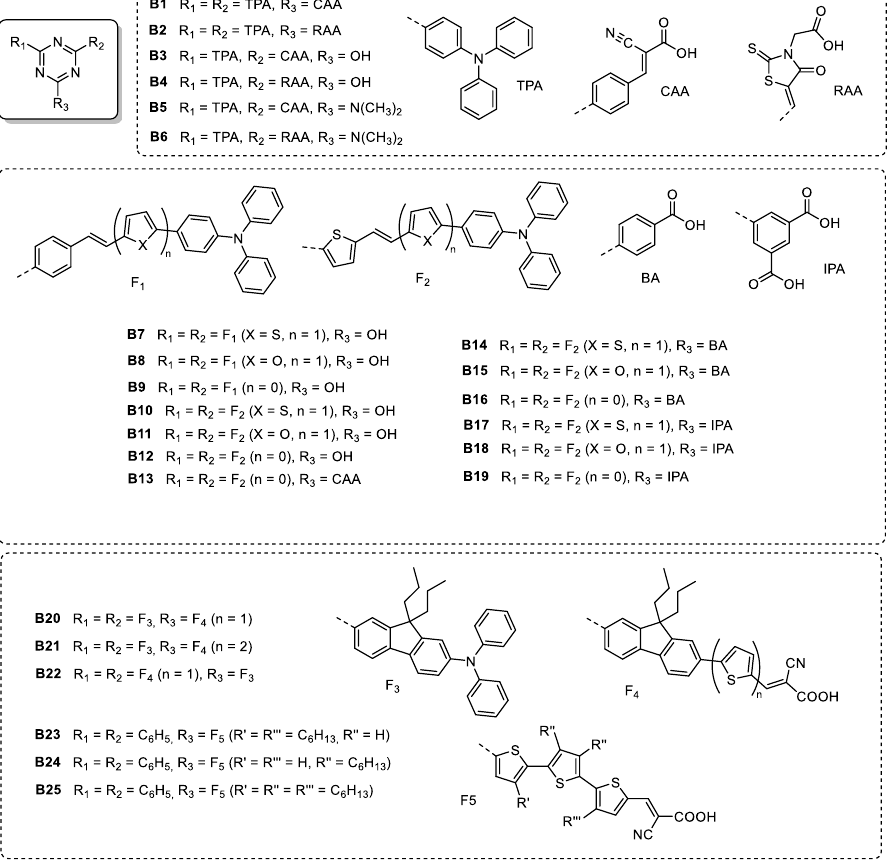
Figure 7. The chemical structures of some representative examples of metal-free triazine-based pho- tosensitizers. Table 2. Optoelectronic properties and performance characteristics of metal-free triazine-based DSSCs. Triazine-Based Mole- cule